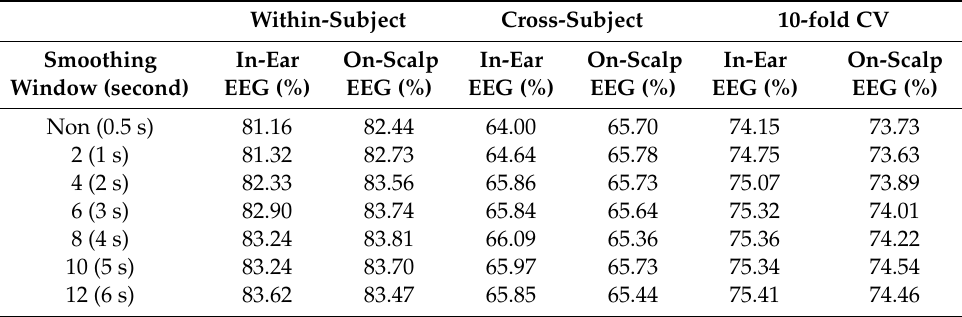
Figure 6. The smoothing of the readout in the ESN. ( a ) The classification results obtained from the original values of the readout fluctuated (black dotted lines: original values of readouts, blue lines: prediction results using original readouts). ( b ) Averaging with previous 6 s outputs corrected the fluctuation (red lines: smoothed readouts using 6 s window). ( c ) The smoothing resulted in improved classification results (blue lines: prediction results using smoothed readouts). Table 4. The performances according to smoothing